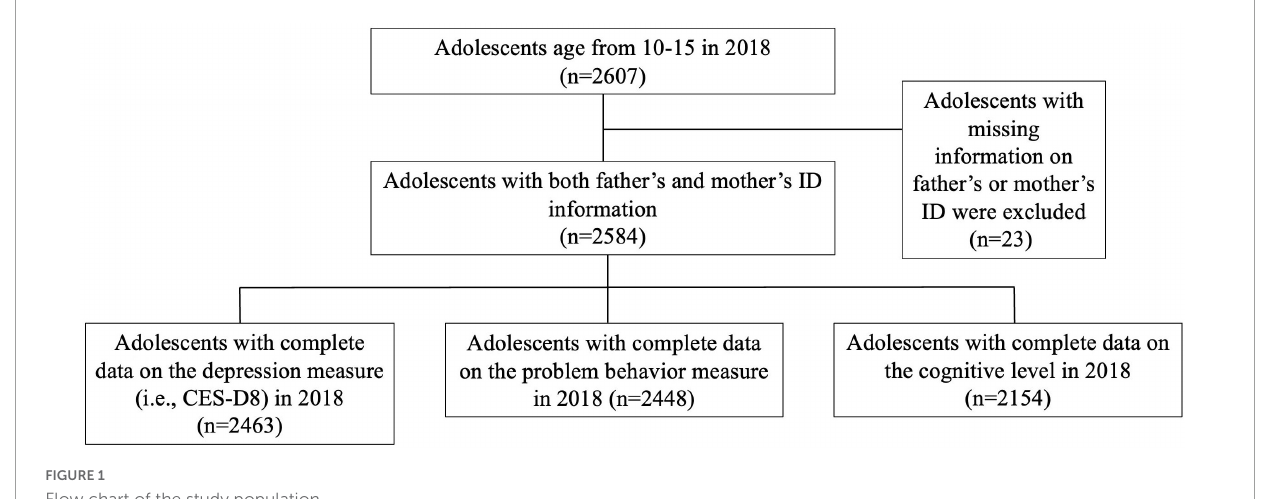
FIGURE1 Flow chart of the study